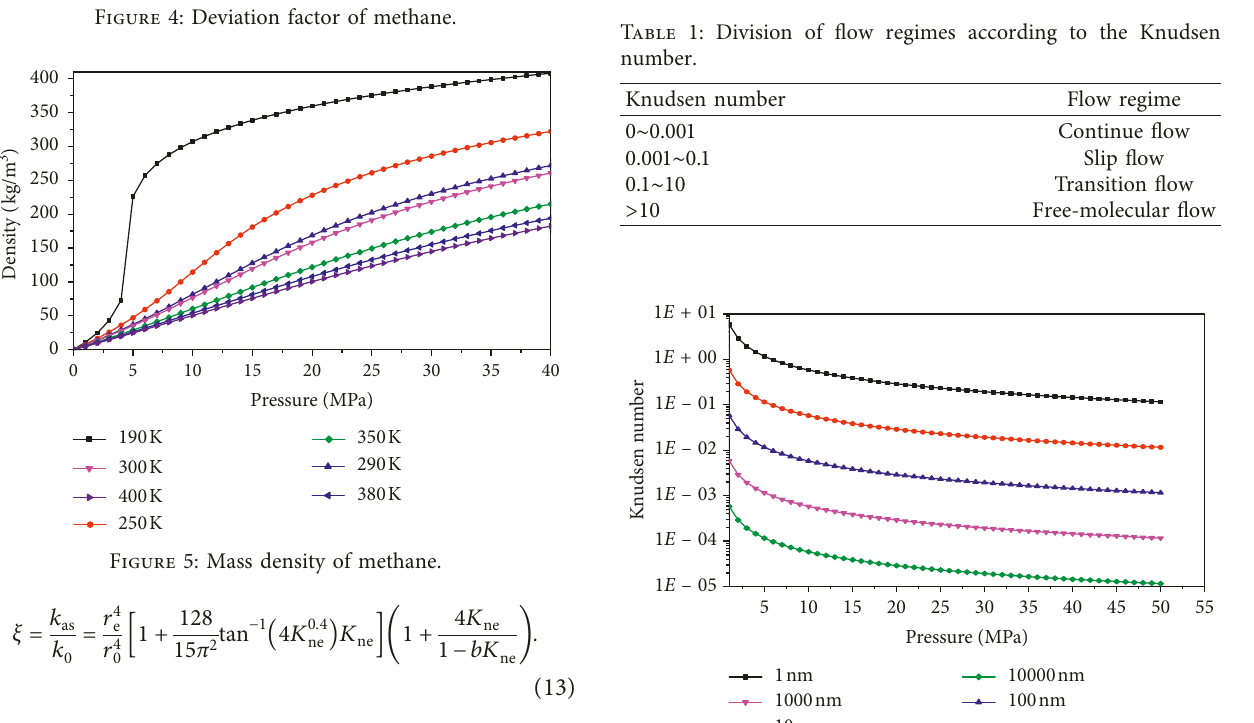
Figure 5: Mass density of methane.